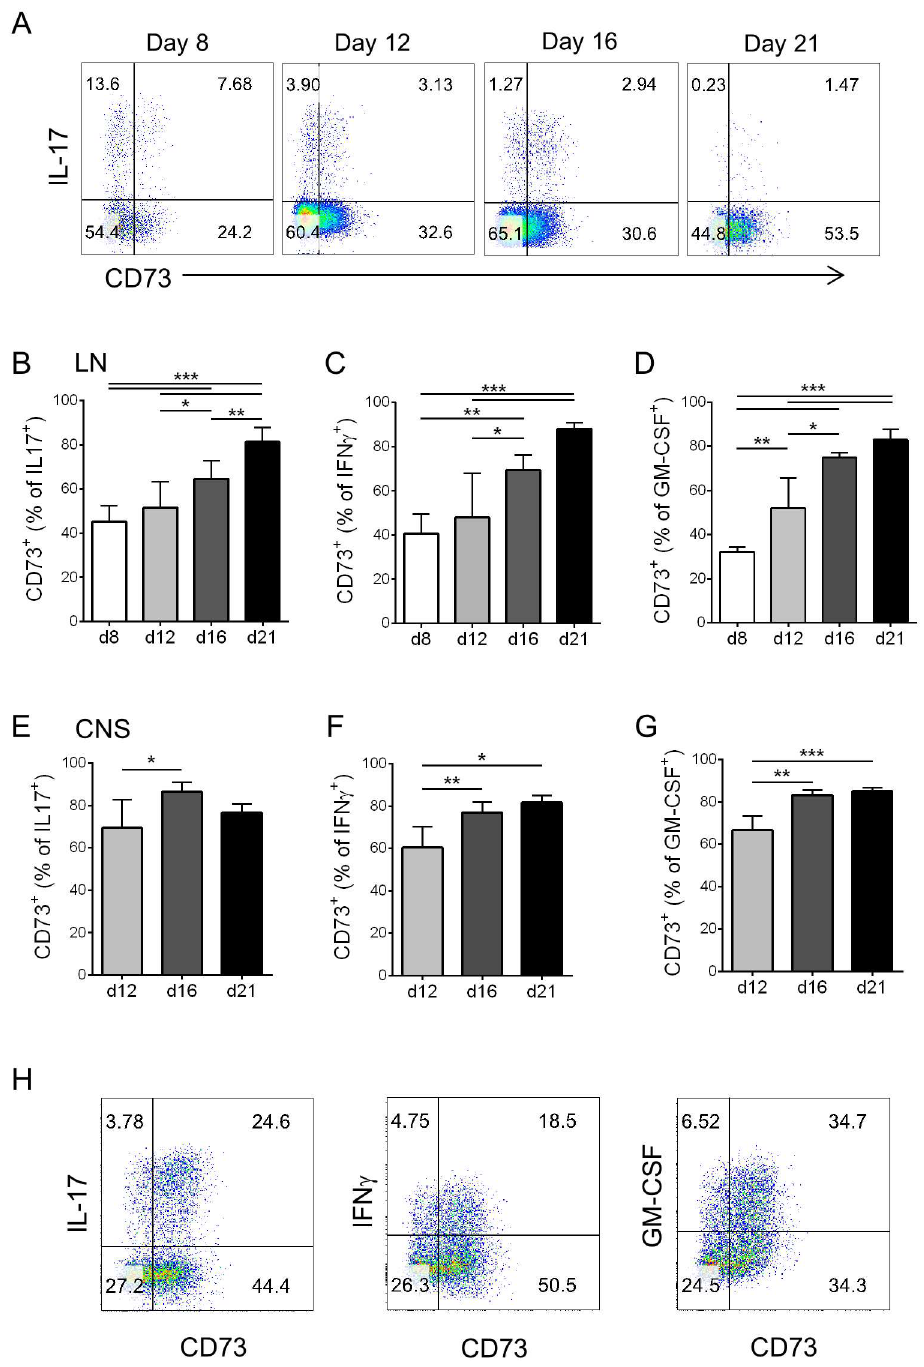
Fig 2. Th17 cells increaseexpression of CD73 during EAE progression. A-D: Analysis of co-expression of CD73on cytokine-producingcells in drainingLN, gated on live CD4 + cells, at indicatedtime-pointspost EAE induction. A: Representative FACS plots. B: Percentageof IL-17 + T cells that express CD73; C: Percentage of IFN γ + T cells that express CD73; D: Percentageof GM-CSF + T cells that express CD73. E-H: Analysis of co-expression of CD73 on cytokine-producingcells in CNS, gated on live CD4 + cells, at indicated time-points post EAE induction.E: Percentage of IL-17 + T cells that express CD73; F: Percentageof IFN γ + T cells that express CD73; G: Percentageof GM-CSF + T cells that express CD73. H: Representative FACS plots showingCD73 and cytokine stainingin live CD4 + T cells from CNS on day 16 of EAE. Valuesin